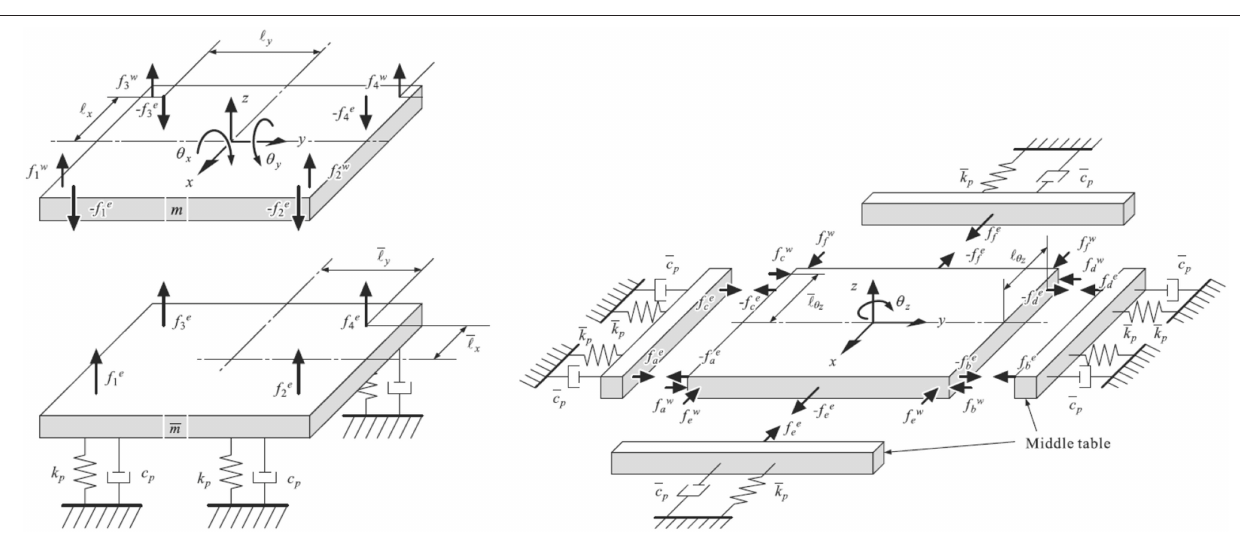
FIGURE 8 | The structural diagram of the solation table for six-axis motions (Hoque et al., 2010).